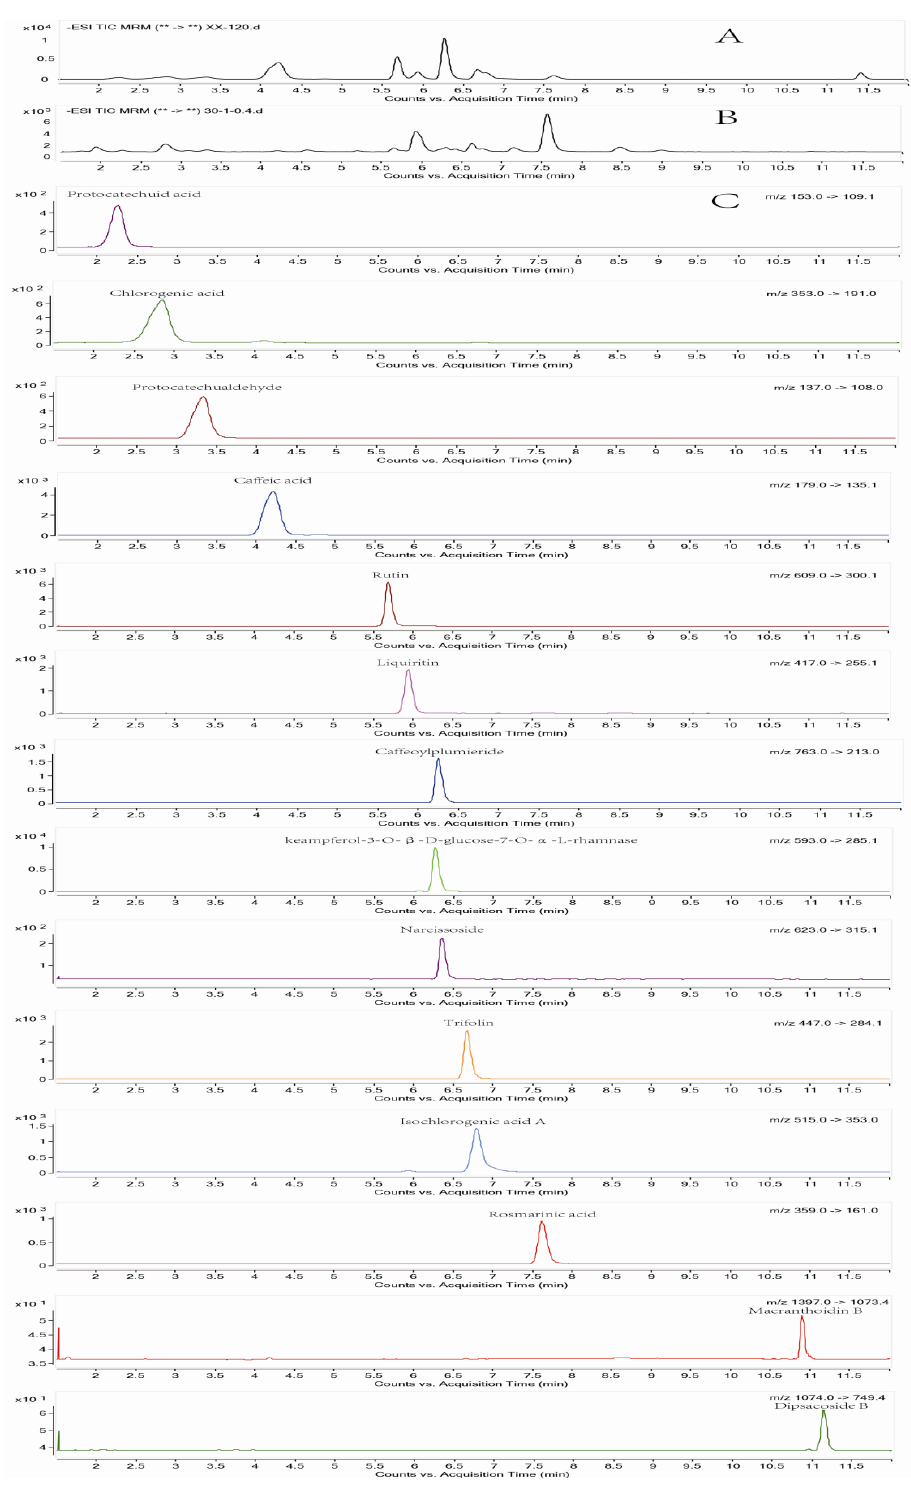
Figure 3. TIC chromatograms obtained by MRM for the negative-ion ESI triple quadrupole MS of 14 reference substance. ( A ) Extracted ion chromatograms of the fourteen reference substances; ( B ) Total ion chromatograms of the samples; ( C ) Extracted ion chromatograms obtained by MRM for negative-ion mode of the fourteen reference substances.